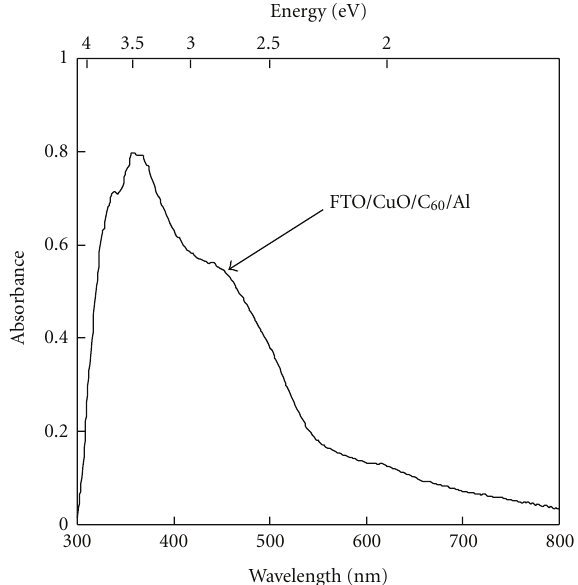
Figure 6: Optical absorption of CuO/C 60 heterojunction solar cell.